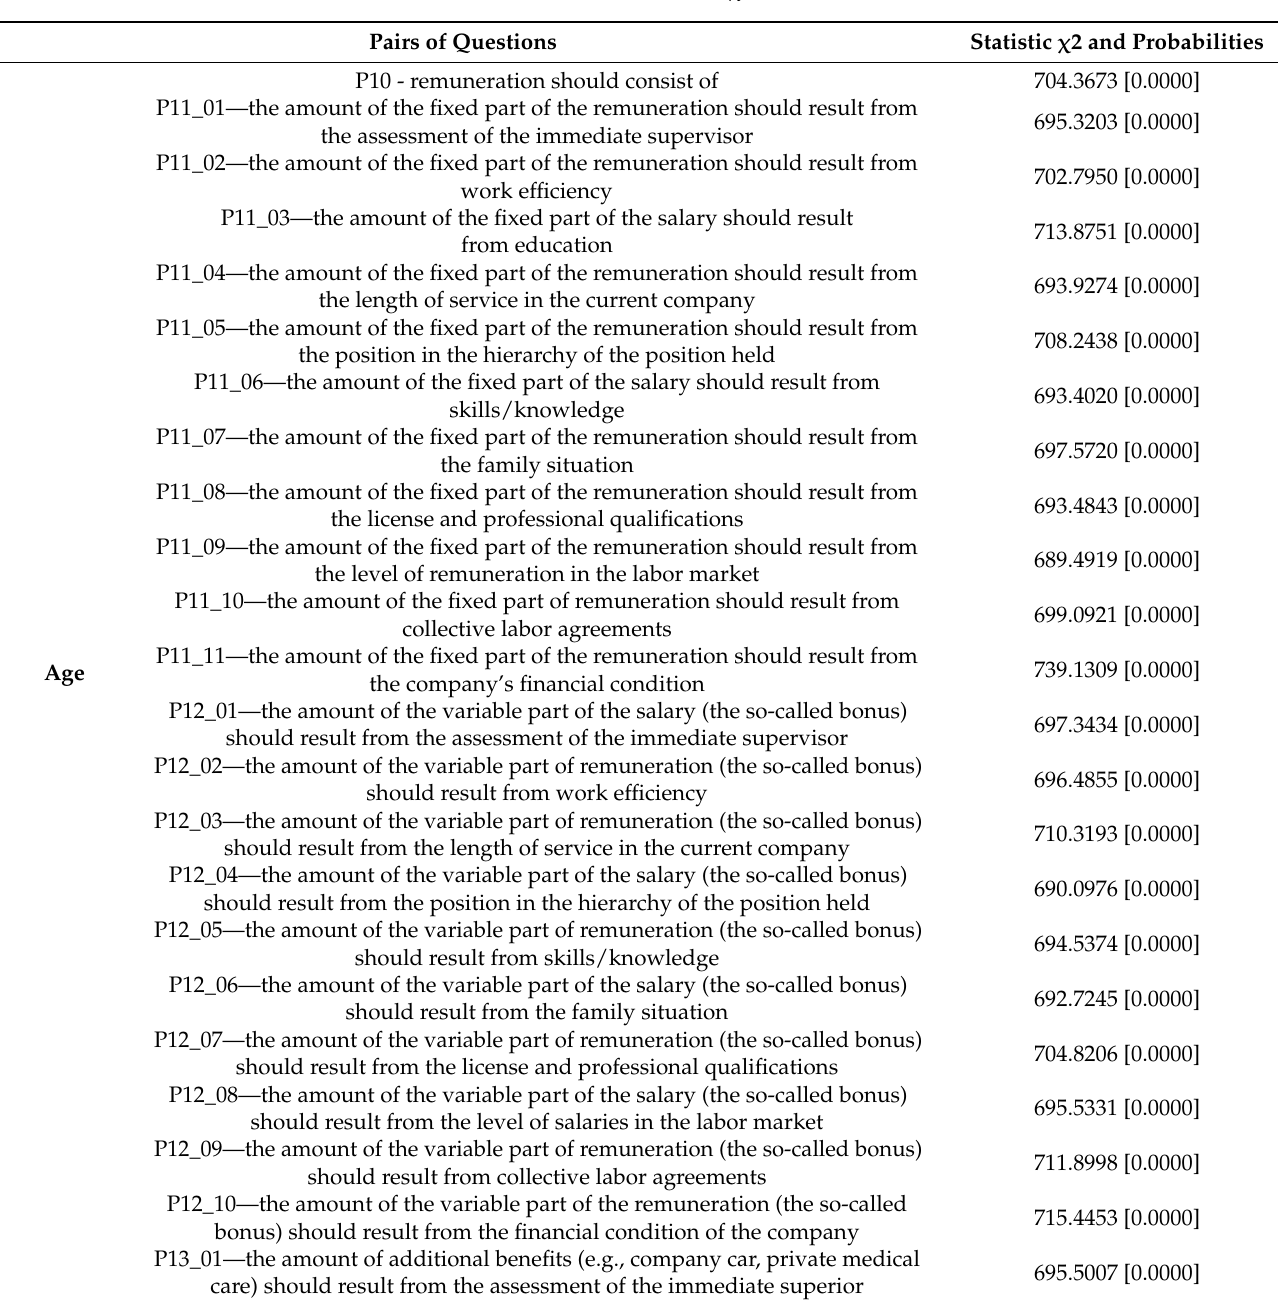
Table 2. The statistic value χ 2